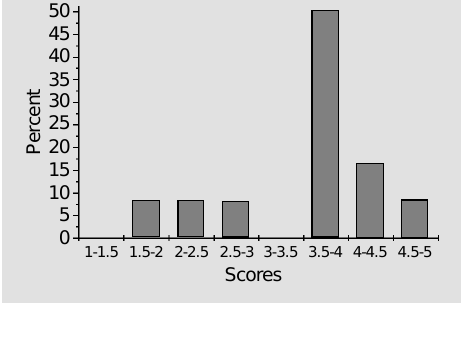
Figure 4 - Scores attributed by the students to the disciplines